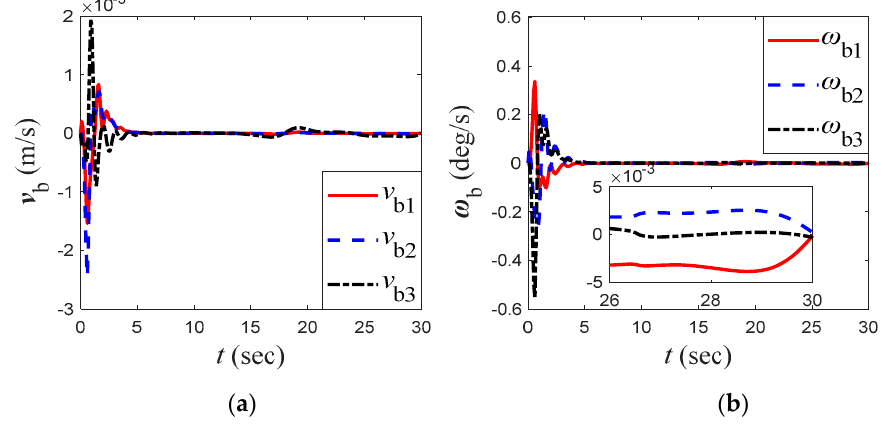
( a ) ( b ) Figure 14. ( a ) Control forces of the platform; ( b ) Torques of the platform. 5.2.2. Comparison with Different Control Laws In order to demonstrate the effectiveness of the RBFNN, we adopt the same ANTSM control law (30) without the estimate of the lumped uncertainty for comparison, that is 3 1 ˆ d × = f 0 . Comparisons of angle tracking errors and sliding manifolds under the ANTSM control law (30) with or without RBFNN are illustrated in Figures 15 and 16, respectively. It is obvious that both the angle errors and the sliding manifolds without NN are much larger than those with NN, which implies the significant role of NN in improving system control accuracy. ( a ) ( b )